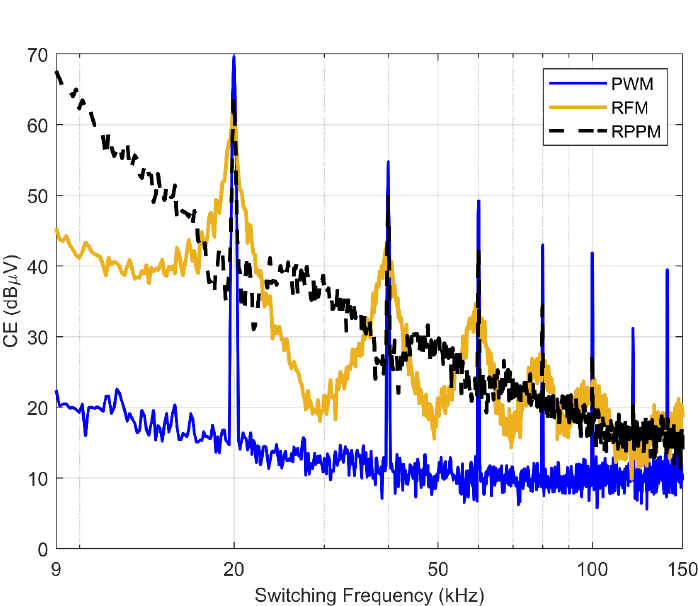
Figure 7. Comparison of the CE exiting the same DC ‐ DC converter driven by different modulation schemes.